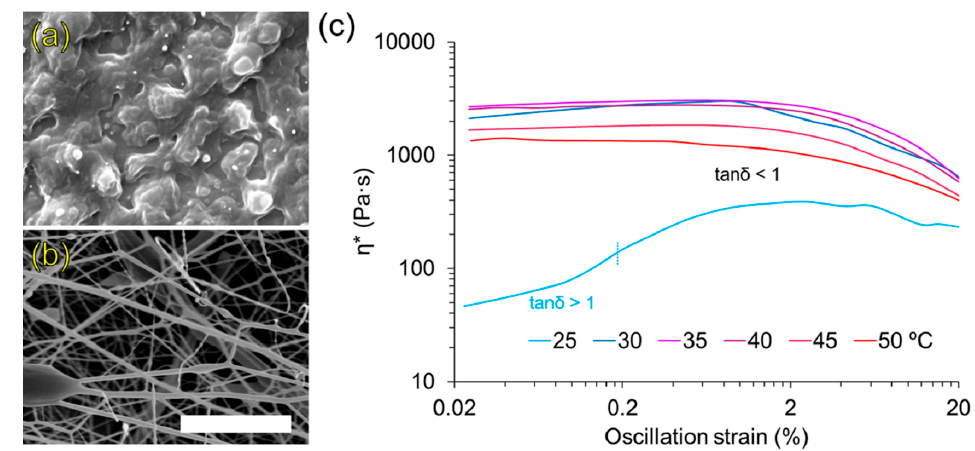
Figure 3. Validation of APsIPN solutions spinnability. SEM micrographs of resulting membranes after electrospinning ( a ) 12 wt % or ( b ) 25 wt % solutions of APsIPN80 in CHCl 3 :MetOH 75:25 (3:1 ratio) at 25 ◦ C. Scale bar: 10 µ m; ( c ) Complex viscosity measurements of APsIPN80 12 wt % solutions in CHCl 3 :MetOH 3:1 at di ff erent temperatures for a wide range of oscillation strains. Samples revealed